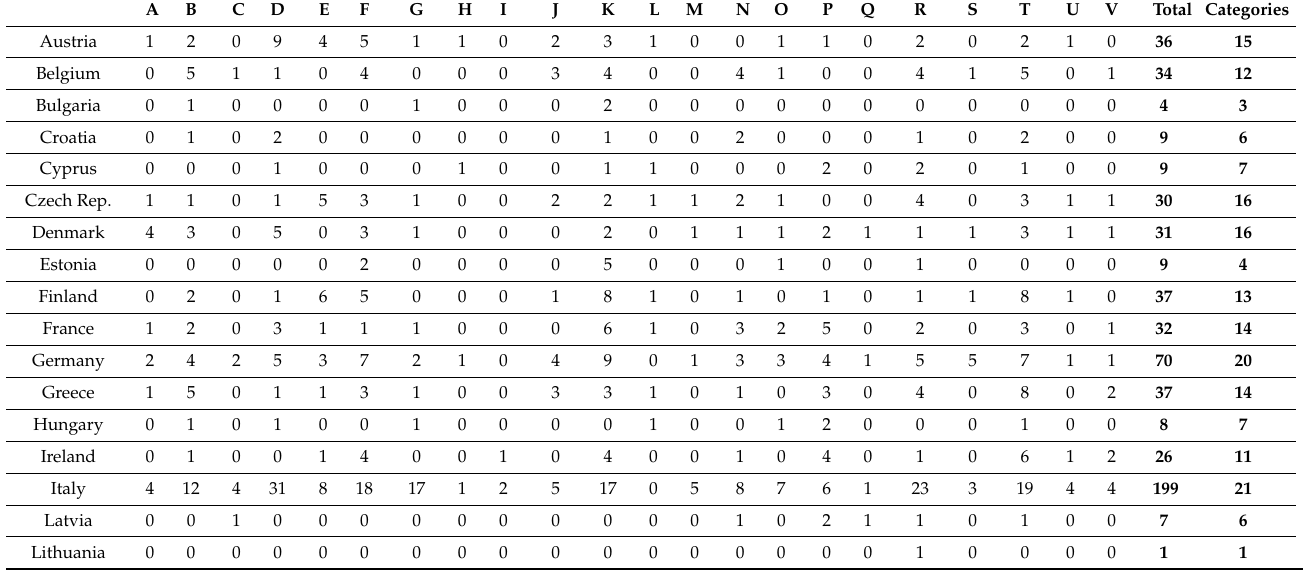
Table A3. Number of Smart City initiatives divided by country and